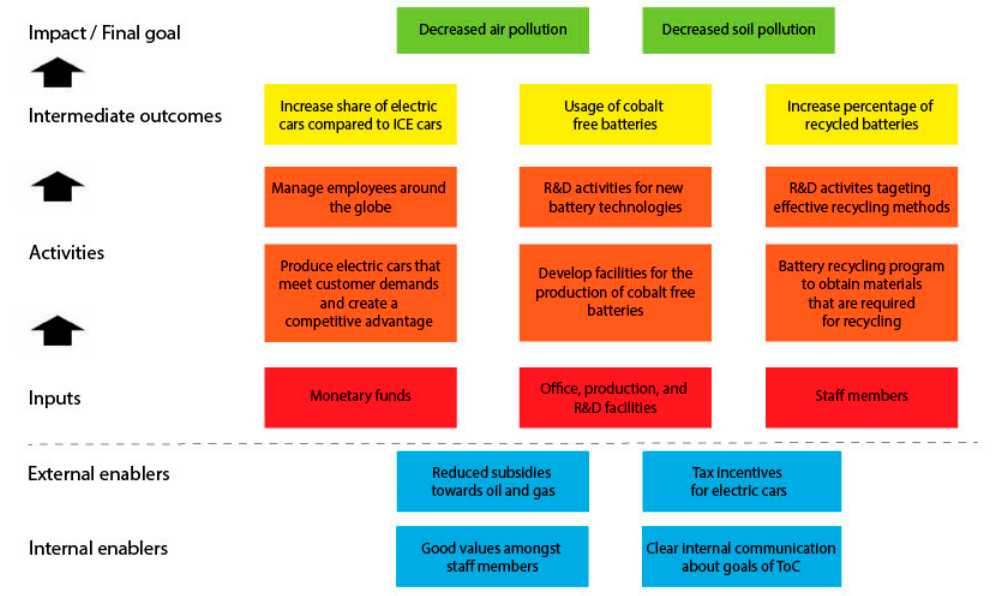
Figure 4. Example of Theory of Change (ToC).